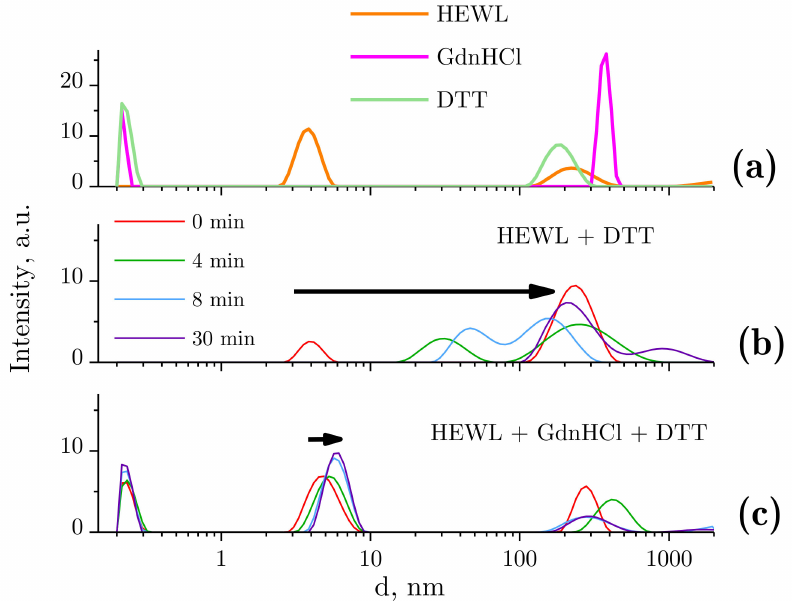
Figure 2. Ordinate axis: peak intensity in arbitrary units, abscissa axis: hydrodynamic diameter d. The data were obtained using dynamic light scattering (DLS). ( a ) Sizes of molecules and molecular aggregates in the following solutions: 4 mg/mL HEWL, 6 M GdnHCl, and 30 mM DTT in 50 mM Tris-HCl (pH = 8.0); ( b ) dynamics of lysozyme molecule sizes with DTT treatment; ( c ) dynamics of lysozyme molecule sizes with GdnHCl and DTT